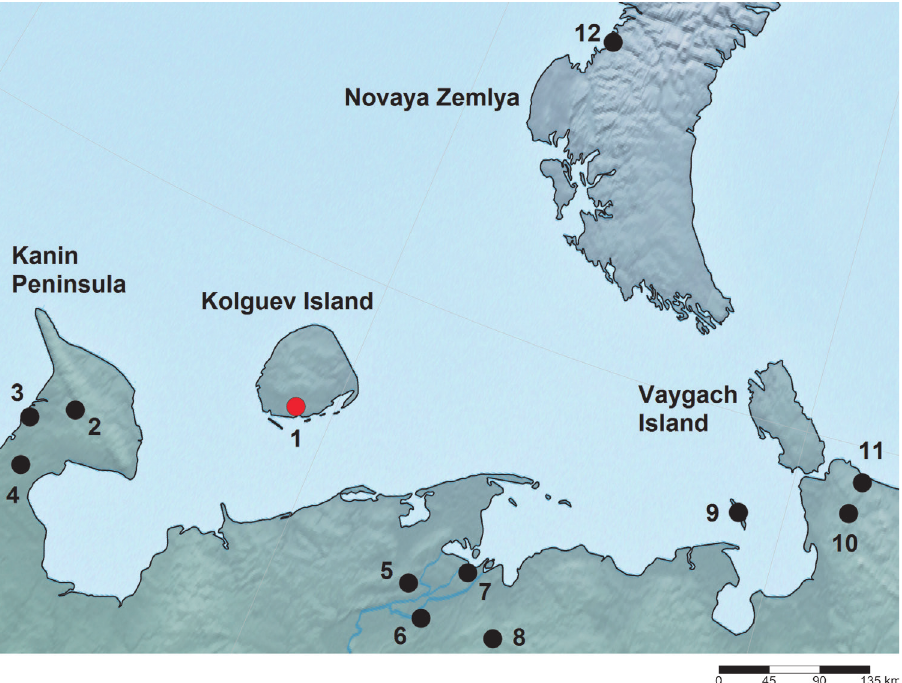
Figure 1. Map of the north-eastern part of European Russia. Records of Boloria frigga are shown as black dots, according the published data. The first record on Kolguev Island is presented as a red dot. Numbers for the localities are given in Table